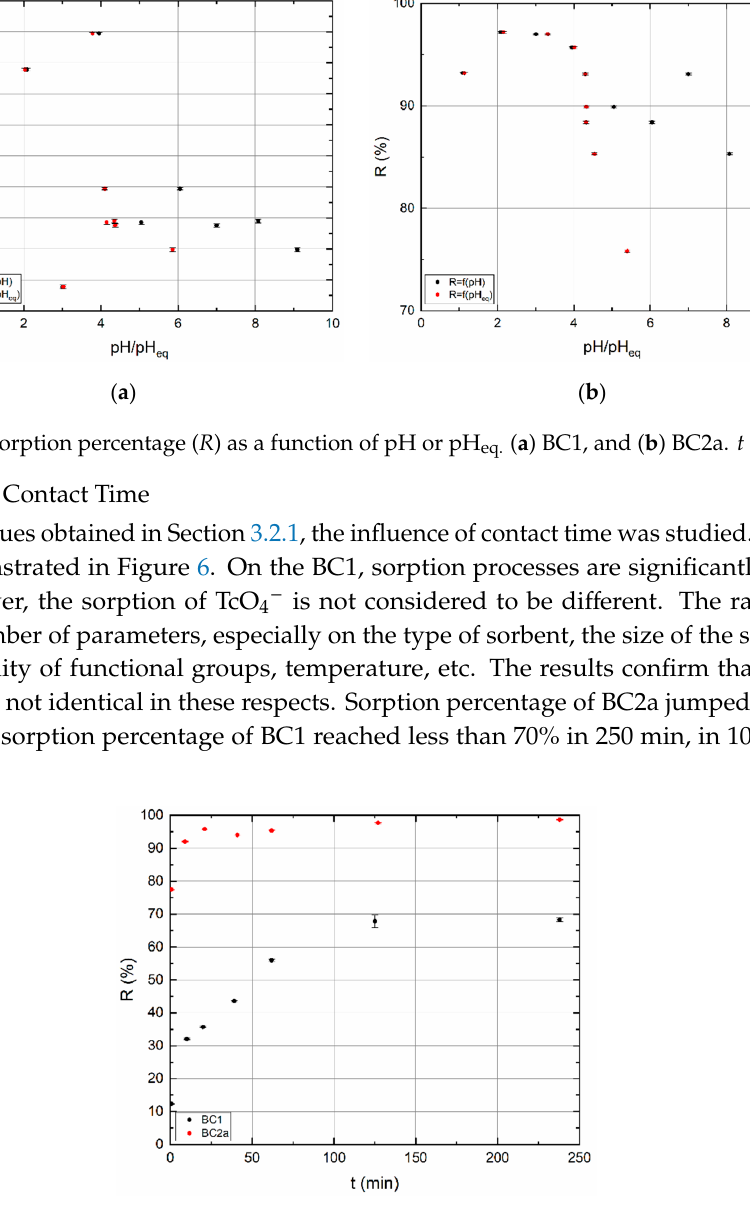
Figure 6. Dependence of sorption percentage ( R ) on contact time ( t ). BC1 pH = 4, BC2a pH = 2.